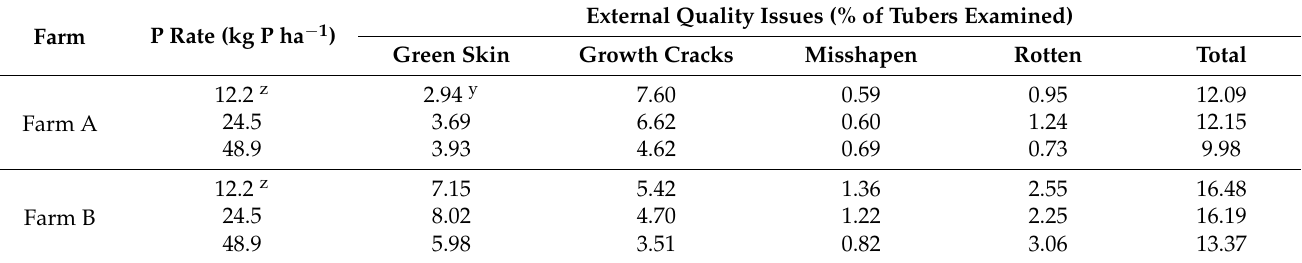
Table 10. External quality of ‘Atlantic’ chipping potato grown on Farms A and B with different P fertilizer applications in the years 2018 and 2019.